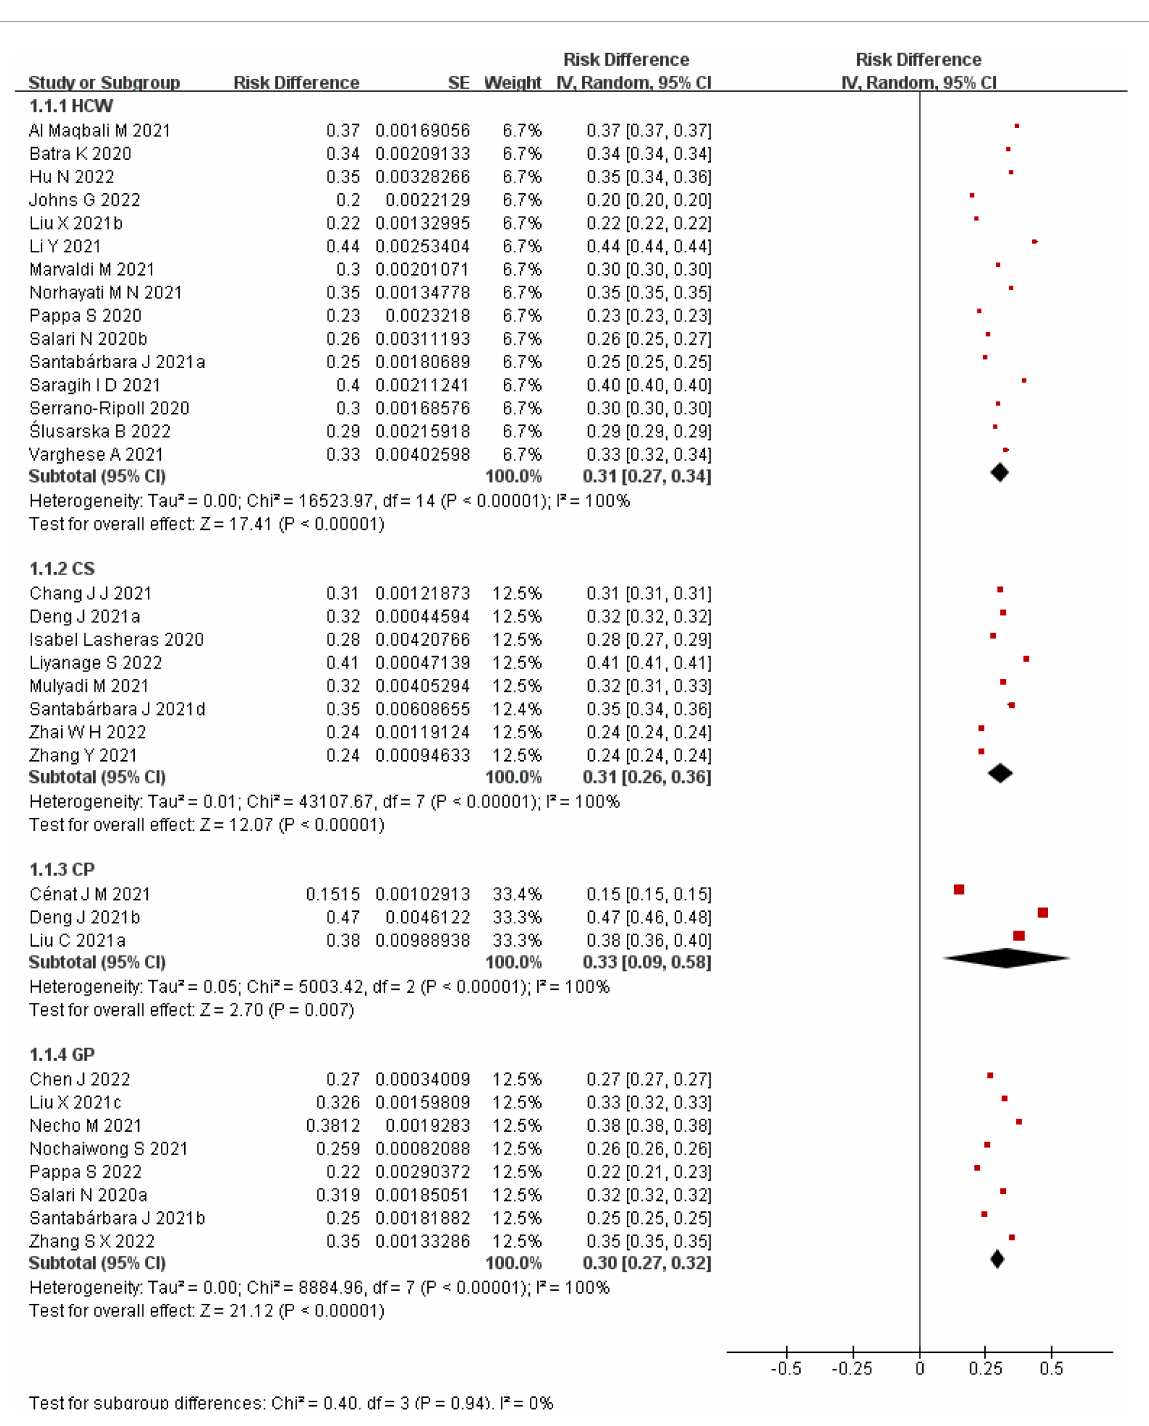
between sleep and psychiatric co-morbidities, especially when more co-morbidities are present (e.g., anxiety and depression), which suggests that sleep specialists treating this suggests that sleep specialists should consider psychiatric co-morbidities